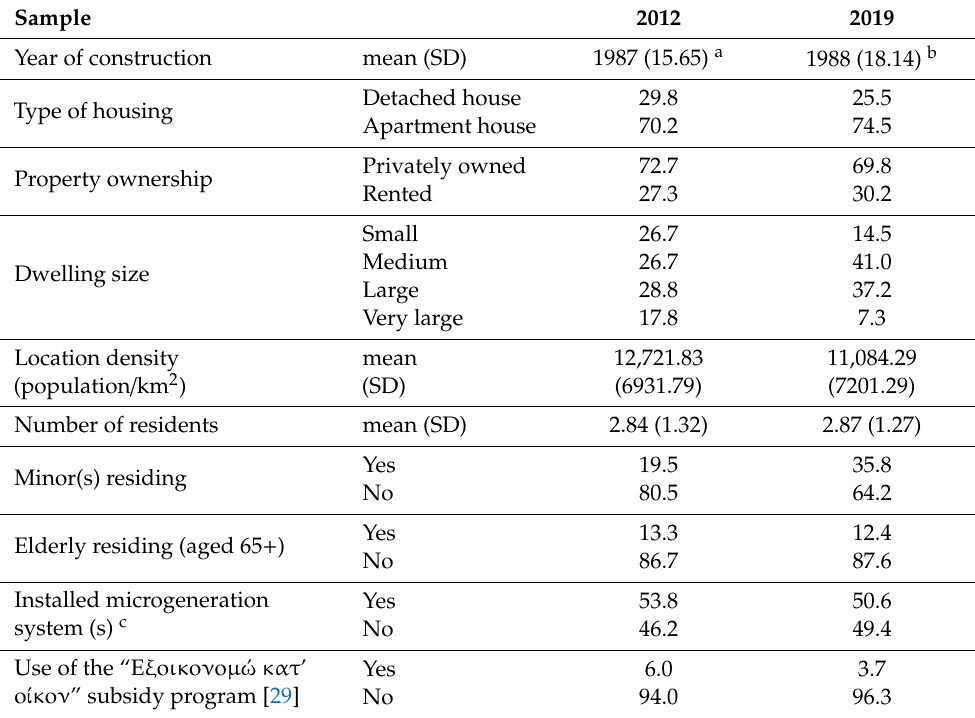
Table 2. Residence